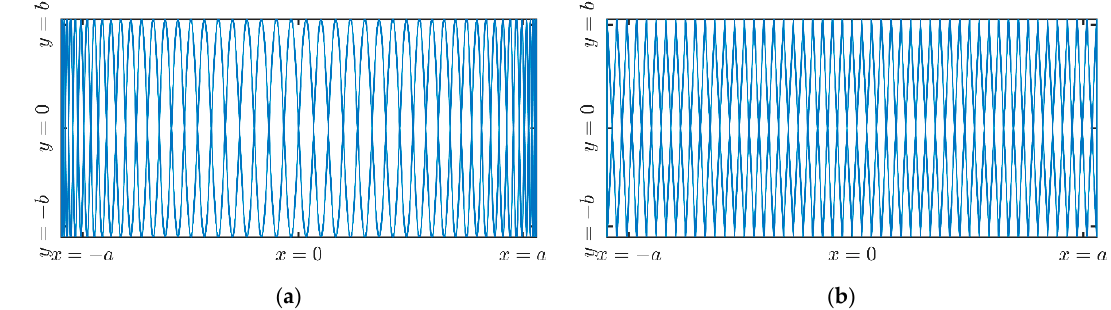
Figure 1. Two different scan strategies of area scanning. ( a ) Lissajous strategy with a sinusoidal rate scan. ( b ) Zigzag strategy with a uniform rate scan.